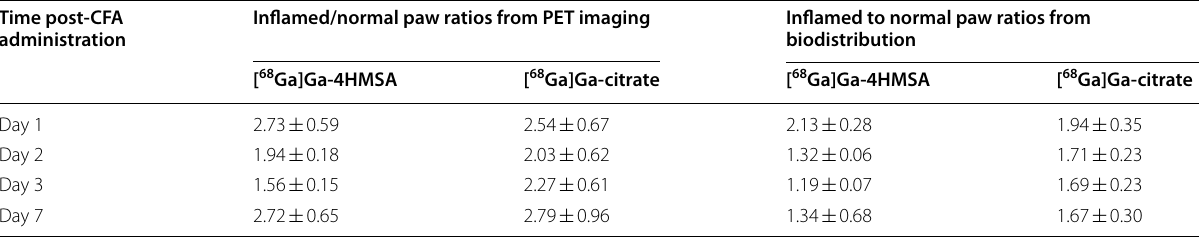
Table 6 Inflamed to normal paw ratios of [ 68 Ga]Ga‑4HMSA and [ 68 Ga]Ga‑citrate from PET imaging and biodistribution results Time post‑CFA Inflamed/normal paw ratios from PET administration